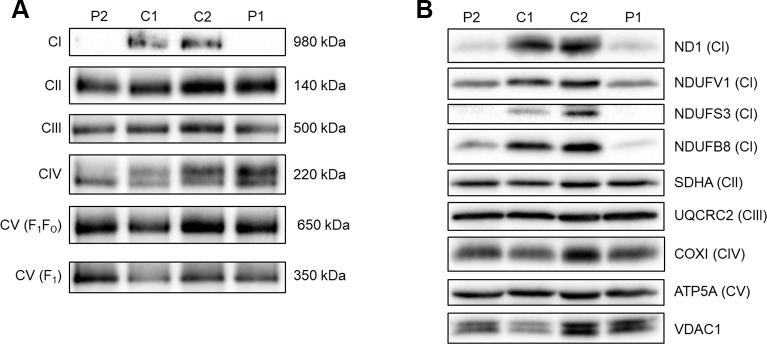
Assessing OXPHOS complex assembly and protein levels in patient muscle. (A) BN-PAGE of muscle samples from two age-matched controls (C1 and C2) and Patients (P1 and P2). Antibodies used were anti-NDUFB8 for complex I (CI), anti-SDHA for complex II (CII), anti-UQCRC2 for complex III (CIII), anti-COX1 for complex IV (CIV), and anti-ATP5A for complex V (CV). Complex II was used as a loading control. Blots are representative of two technical repeats. (B) SDS-PAGE and immunoblotting analysis of muscle samples from two age-matched controls (C1 and C2) and Patients (P1 and P2). Antibodies against ND1, NDUFV1, NDUFS3, NDUFB8 were used as markers of complex I; SDHA for complex II; UQCRC2 for complex III; COXI for complex IV; ATP5A for complex V and VDAC1 as a mitochondrial mass marker. Blots are representative of two independent experiments.